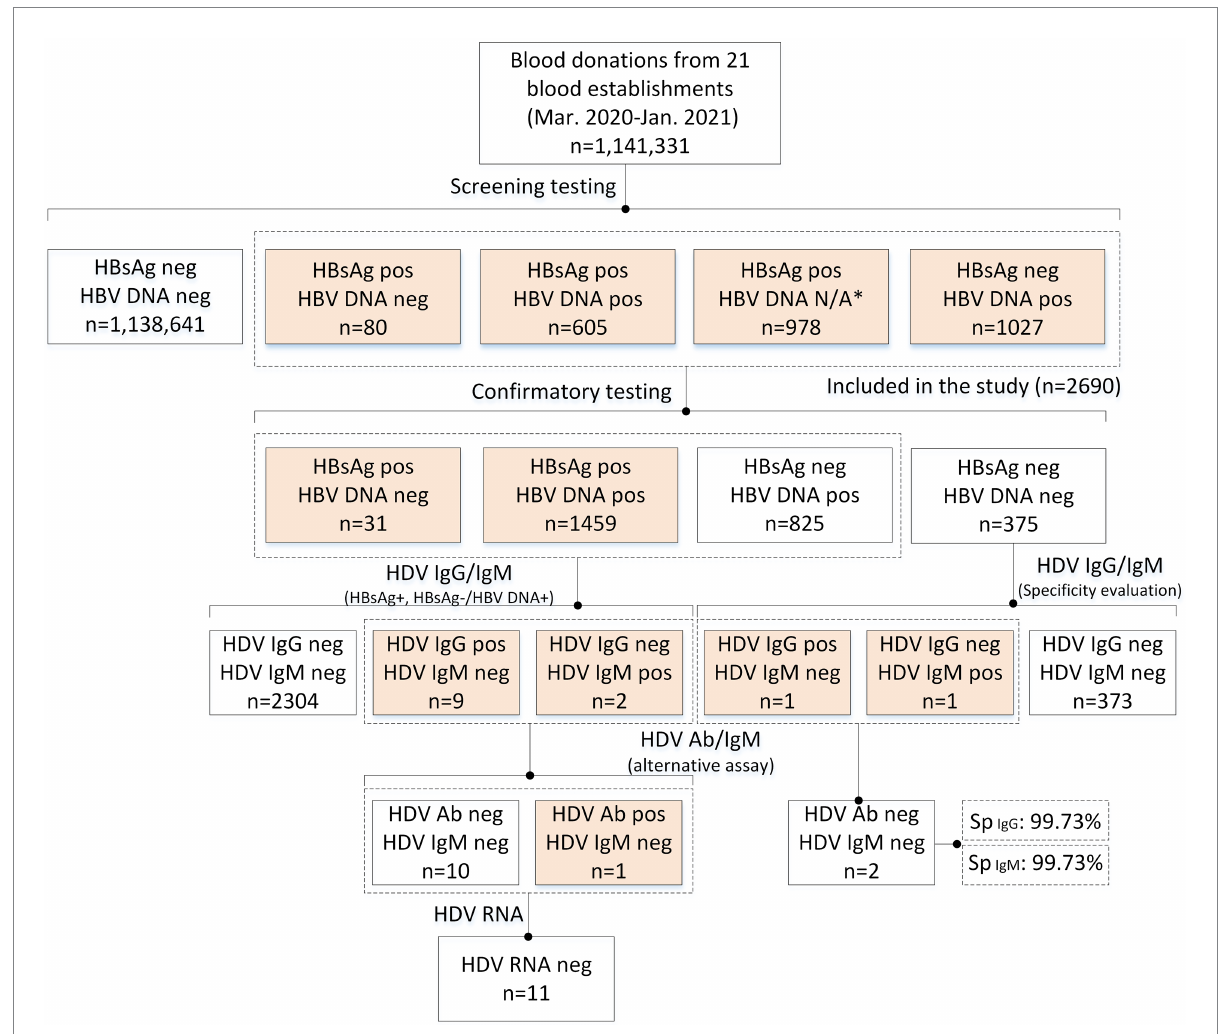
FIGURE 3 Flow chart of the study. Pos/+, positive/reactive; neg/ − , negative/nonreactive; N/A,